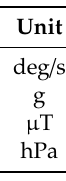
Figure 3. Inertial Measurement Unit (IMU) worn on a leg. Table 3. List of measured parameters using wearable